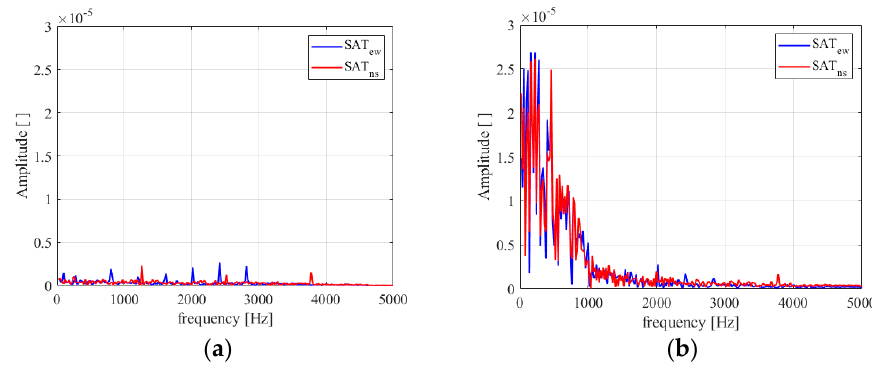
Figure 2. Illustrative spectra describing an operational phase without a rotating mode (left, a , at 2.5 s with a time window of 50 ms) or a fast rotating one (right, b ) on the left and with a rotating mode on the right at 2.74 s for the pulse 30799, which disrupts at 2.79 s.